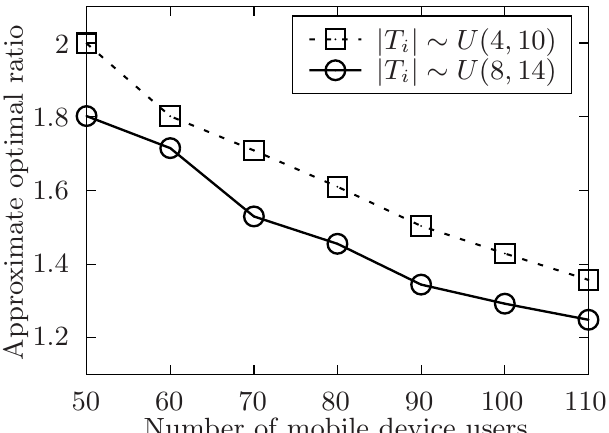
Figure 6. The approximate optimal ratio of the proposed algorithm vs. different n when | T i | ∼ U ( 4,10 ) or U ( 8,14 )